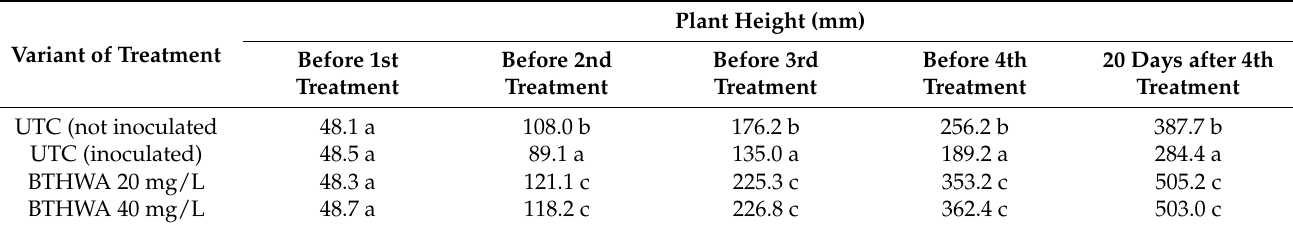
Table 2. Influence of tested variants of treatment on the height of tulips.